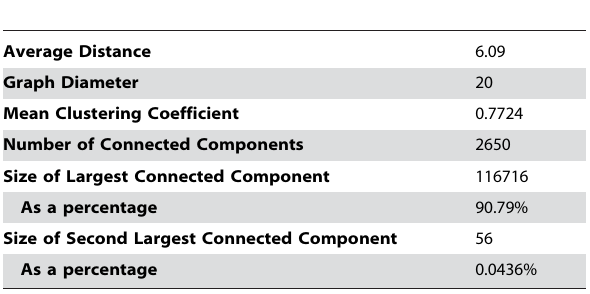
Table 4. Some graph analysis results for multi-year SFN